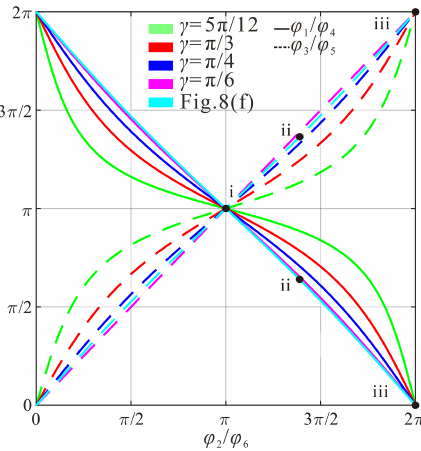
Figure 9. The kinematic curves for scheme III among upper- dihedral angles ϕ 1 , ϕ 3 , ϕ 4 , ϕ 5 vs. ϕ 2 ( ϕ 6